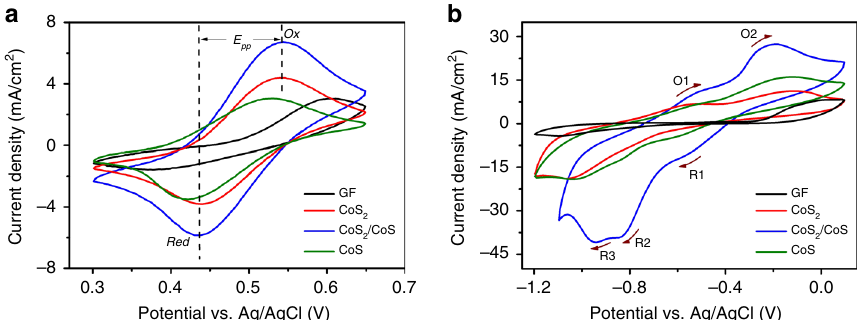
Fig. 4 Cyclic voltammetry characterization. The cyclic voltammograms (CVs) of the catalysts deposited on glassy carbon in 4 mM NaI + 0.5 M NaCl solution ( a ) and 0.06 M Na 2 S + 0.02 M S + 0.5 M NaCl solution ( b ) at a scan rate of 50 mV s − 1